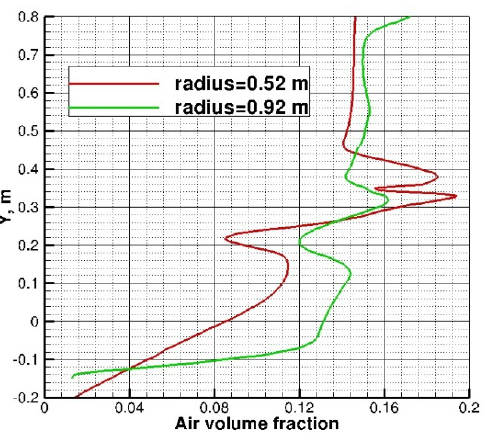
Figure 5. ( a ) Air volume fraction (α) at r = 0.52 (red) and 0.92 m (green); ( b ) Air superficial radial velocity ( V ) at r = 0.52 (red) and 0.92 m (green); and ( c ) Water a , radial superficial radial velocity ( V ) at r = 0.52 (red) and 0.92 m w , radial